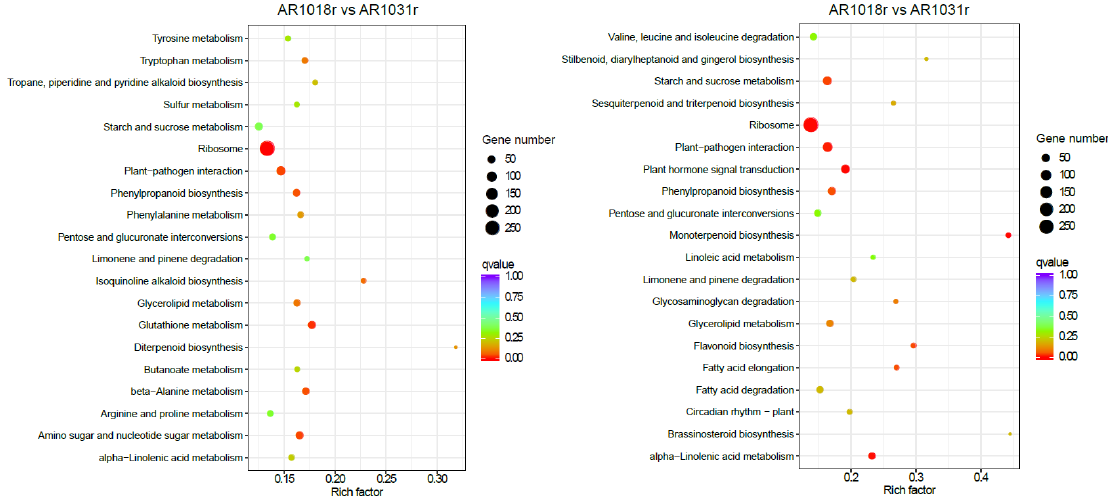
Figure 9. Kyoto Encyclopedia of Genes and Genomes (KEGG) pathway analysis of the DEGs.